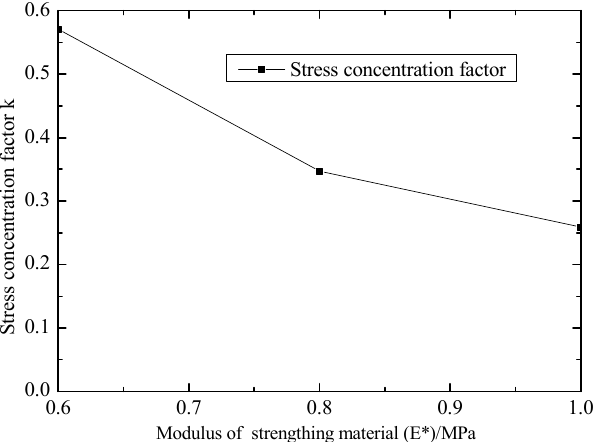
Figure 9. E ff ect of modulus of strengthening material on stress concentration factor. Figure 9. Effect of modulus of strengthening material on stress concentration factor.